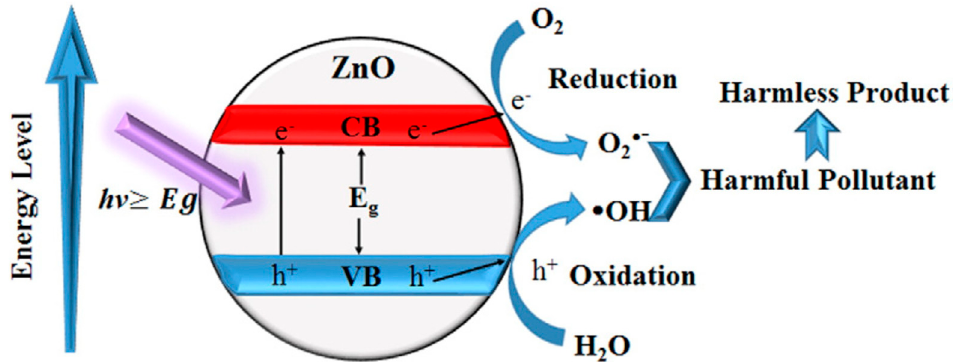
Figure 24. Schematic illustration of the formation of charge carriers (e – and h + ) and photocatalytic degradation of pollutants on the ZnO nanostructured surface. Reproduced with permission from Elsevier [154].